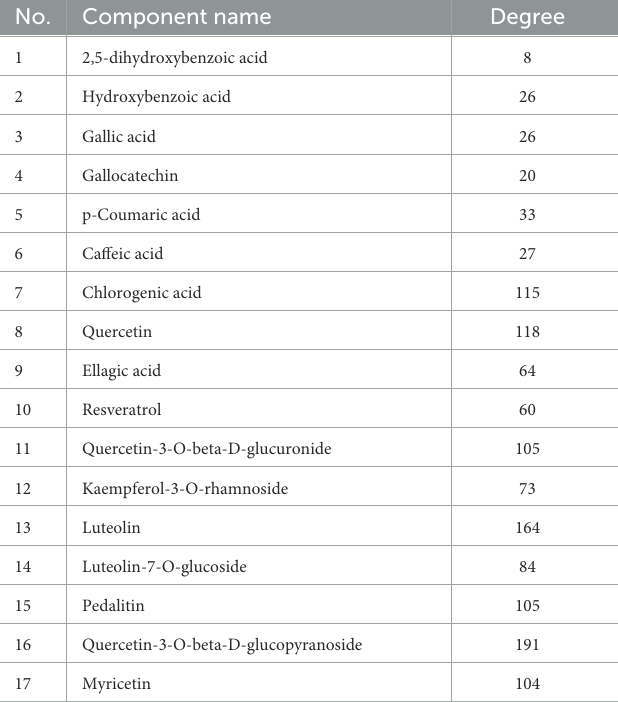
TABLE 2 Active ingredients of hazel leaf